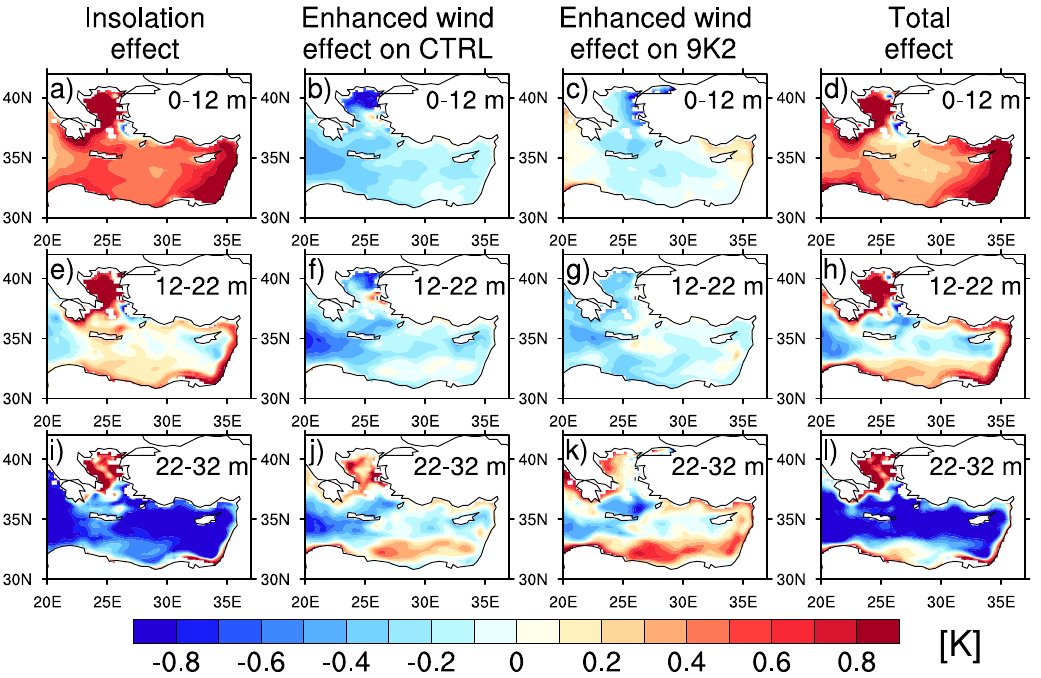
Fig. 17. Anomalies of temperature for different model depth layers for summer (JAS). The columns show the isolated effect of insolation forcing (9K2-W0 vs. CTRL), enhanced Etesian winds on CTRL climate (CTRL-W9 vs. CTRL) and on 9K2 climate (9K2 vs. 9K2-W0), as well as the total effect of both factors (9K2 vs. CTRL).